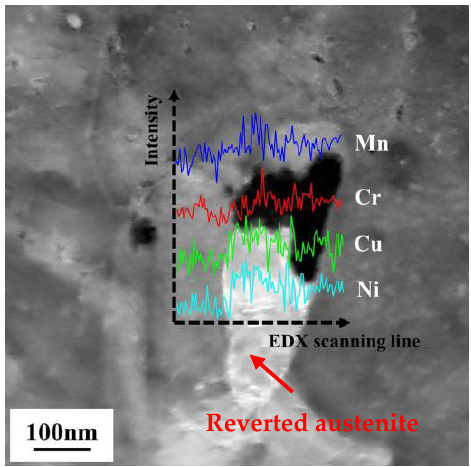
Figure 6. Scanning transmission electron microscopy-high angle annular dark field (STEM-HAADF) micrograph of the reverted austenite in the sample aged at 650 °C and EDX line-scanning results along the horizontal dark arrow line.